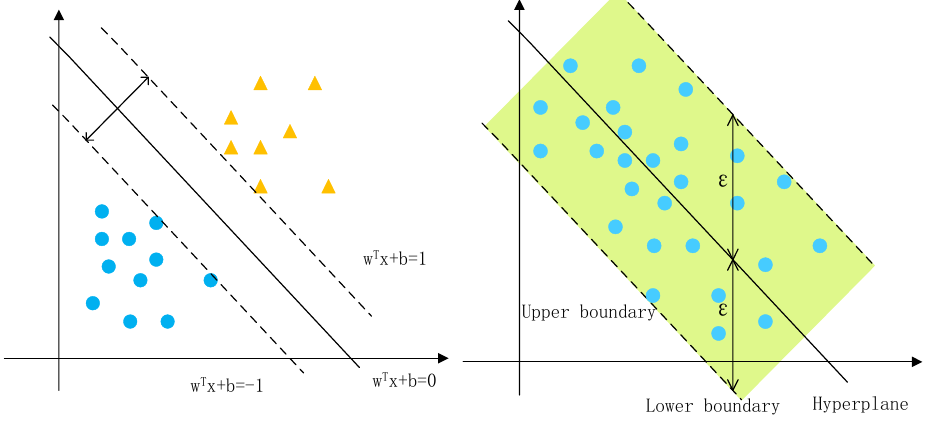
Figure 5. SVM and